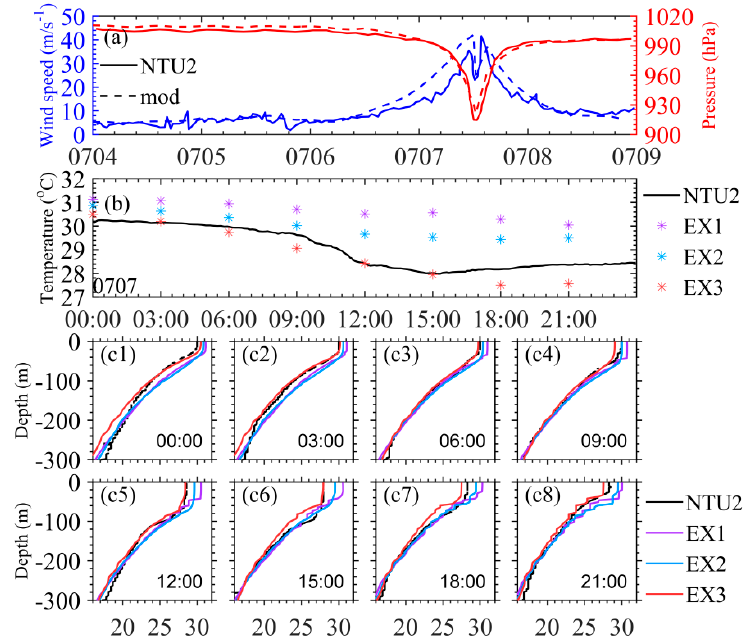
Figure 7. Comparisons between the model data and the NTU2 data. ( a ) Wind speed and pressure. ( b ) Upper 25 m-averaged temperature, the time axis indicates the model output time. ( c ) Temperature profiles at the corresponding moment ticked in b. Table 3. Comparisons of the T 25m between the buoy observations and numerical experiments during the TC.